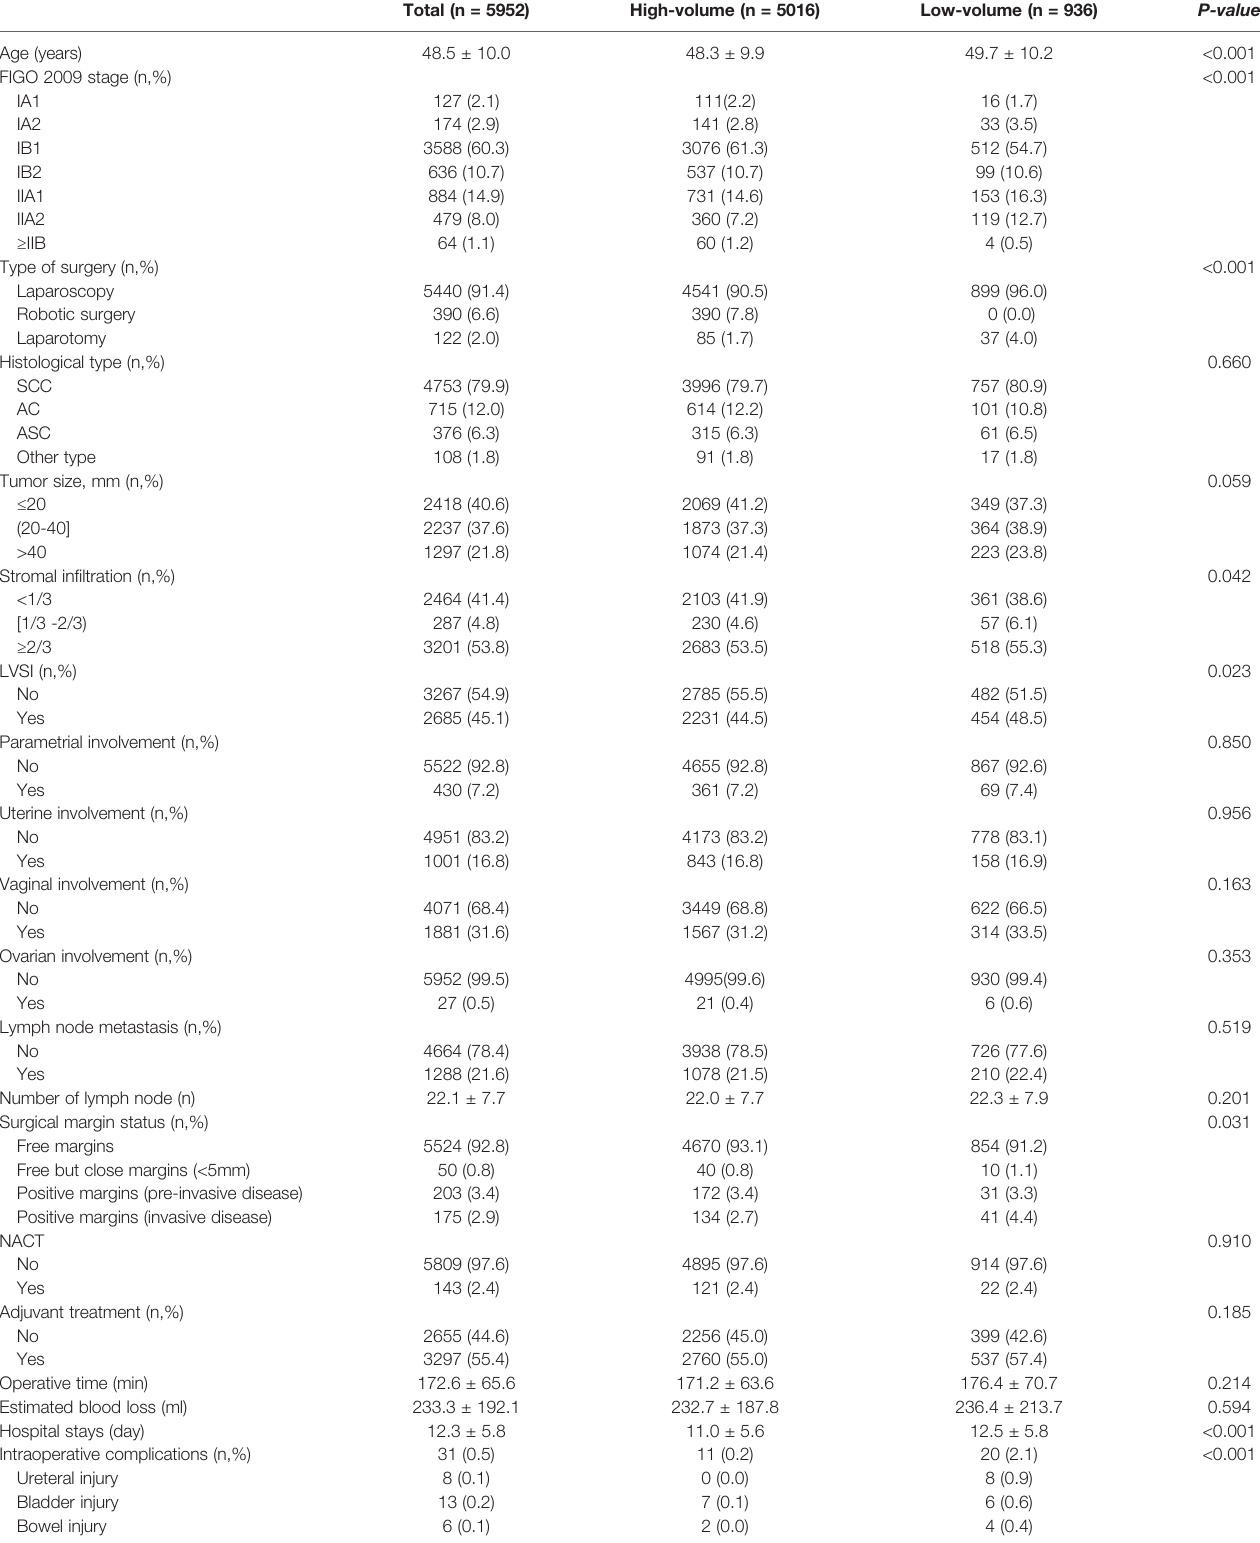
TABLE 3 | Comparison of clinical, pathologic and operative characteristics between the high-volume and the low-volume